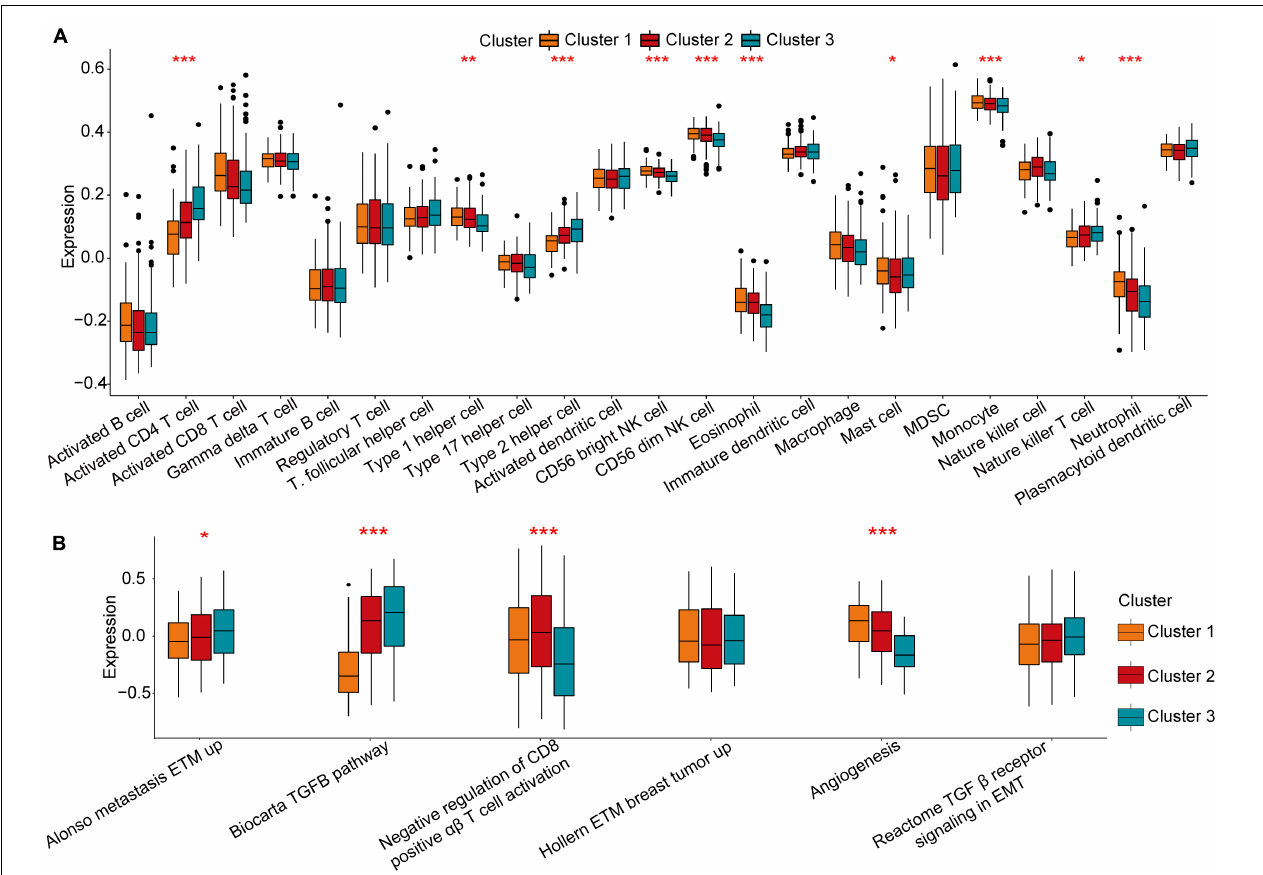
FIGURE 3 | Tumour microenvironment characteristics in different m 5 C modification patterns. (A) Comparison of the abundance of immune infiltrating cells in three clusters. (B) Differences in cellular biological pathways among the three clusters. * p < 0.05, ** p < 0.01, *** p < 0.001.